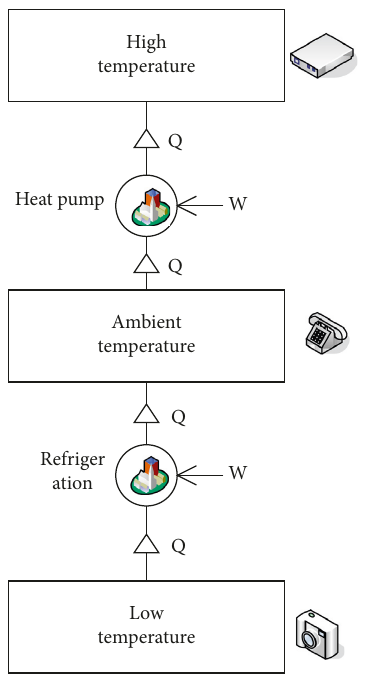
Figure 3: Working principle of an air-source heat